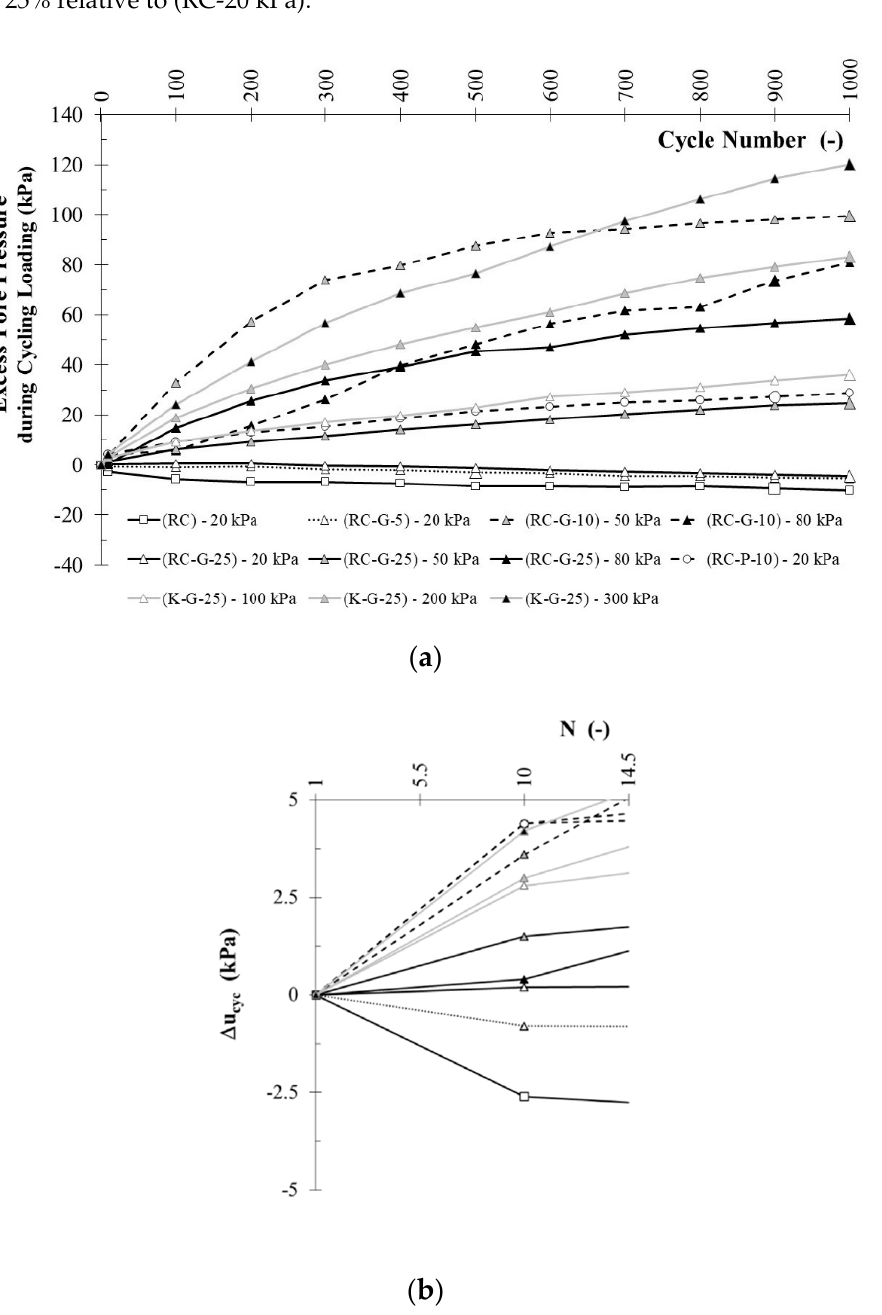
Figure 8. Variation of the pore pressure u cyc with the cycle number N from: ( a ) 1–1000 cycles; ( b ) 1–10 cycles. Table 4. Specification of axial strain ε 1,cyc and pore pressure u cyc values during triaxial tests after 10/100/1000/10,000 cycles at amplitude A = 0.35 q .